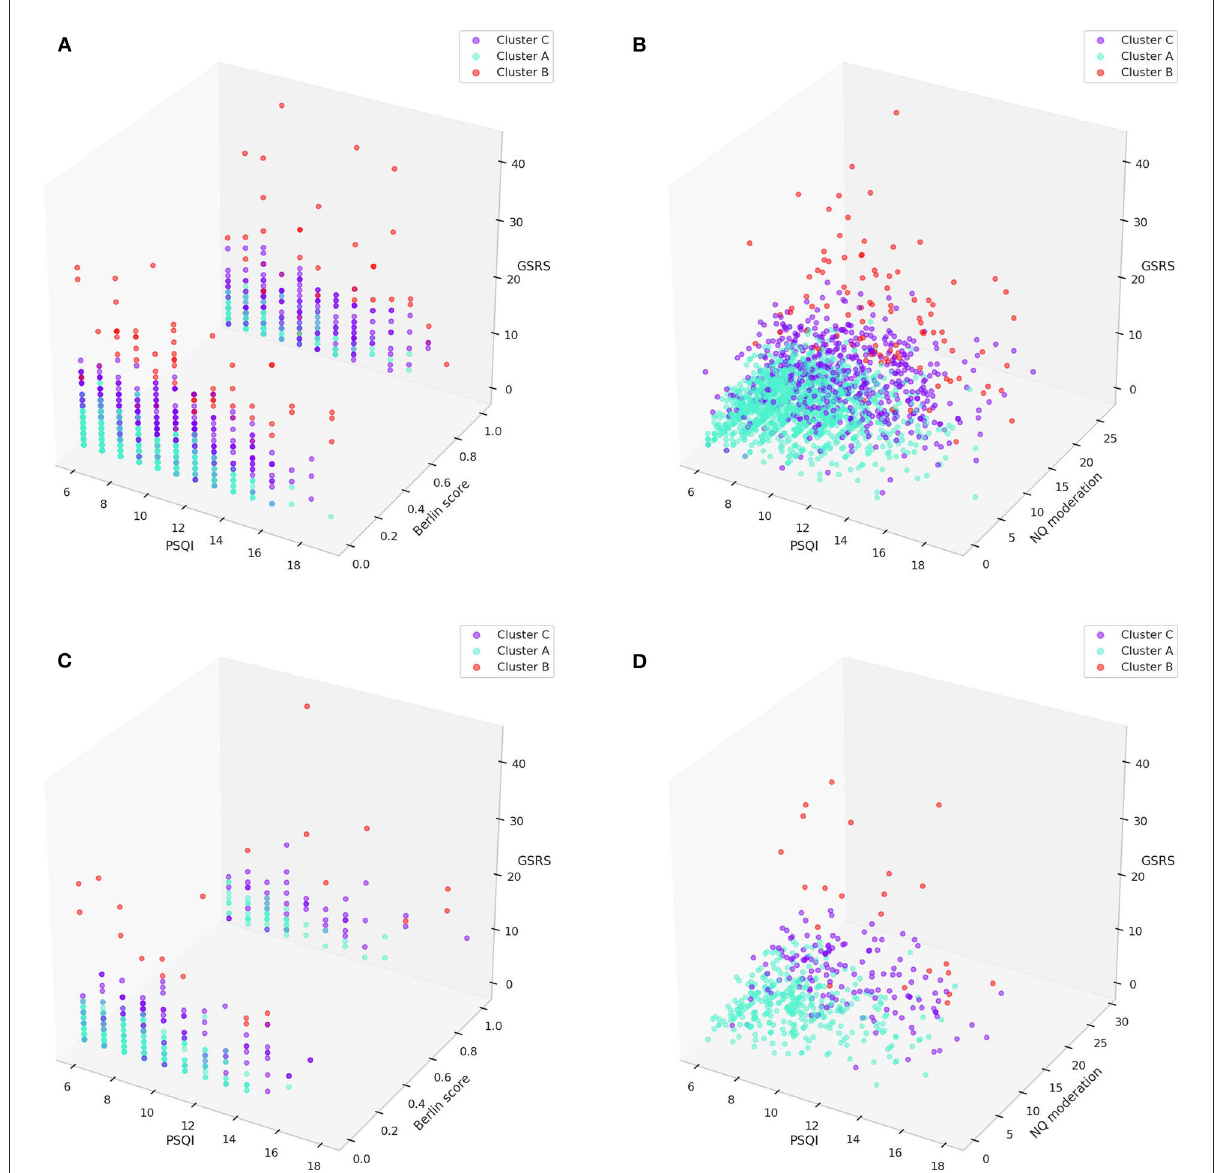
FIGURE7 3D visualization of clusters with major components (PSQI, Berlin, GSRS scores, and NQ moderation) in the training set (A,B) and test set (C,D) . GSRS, gastrointestinal symptom rating scale; NQ, nutrition quotient; PSQI, Pittsburgh sleep quality